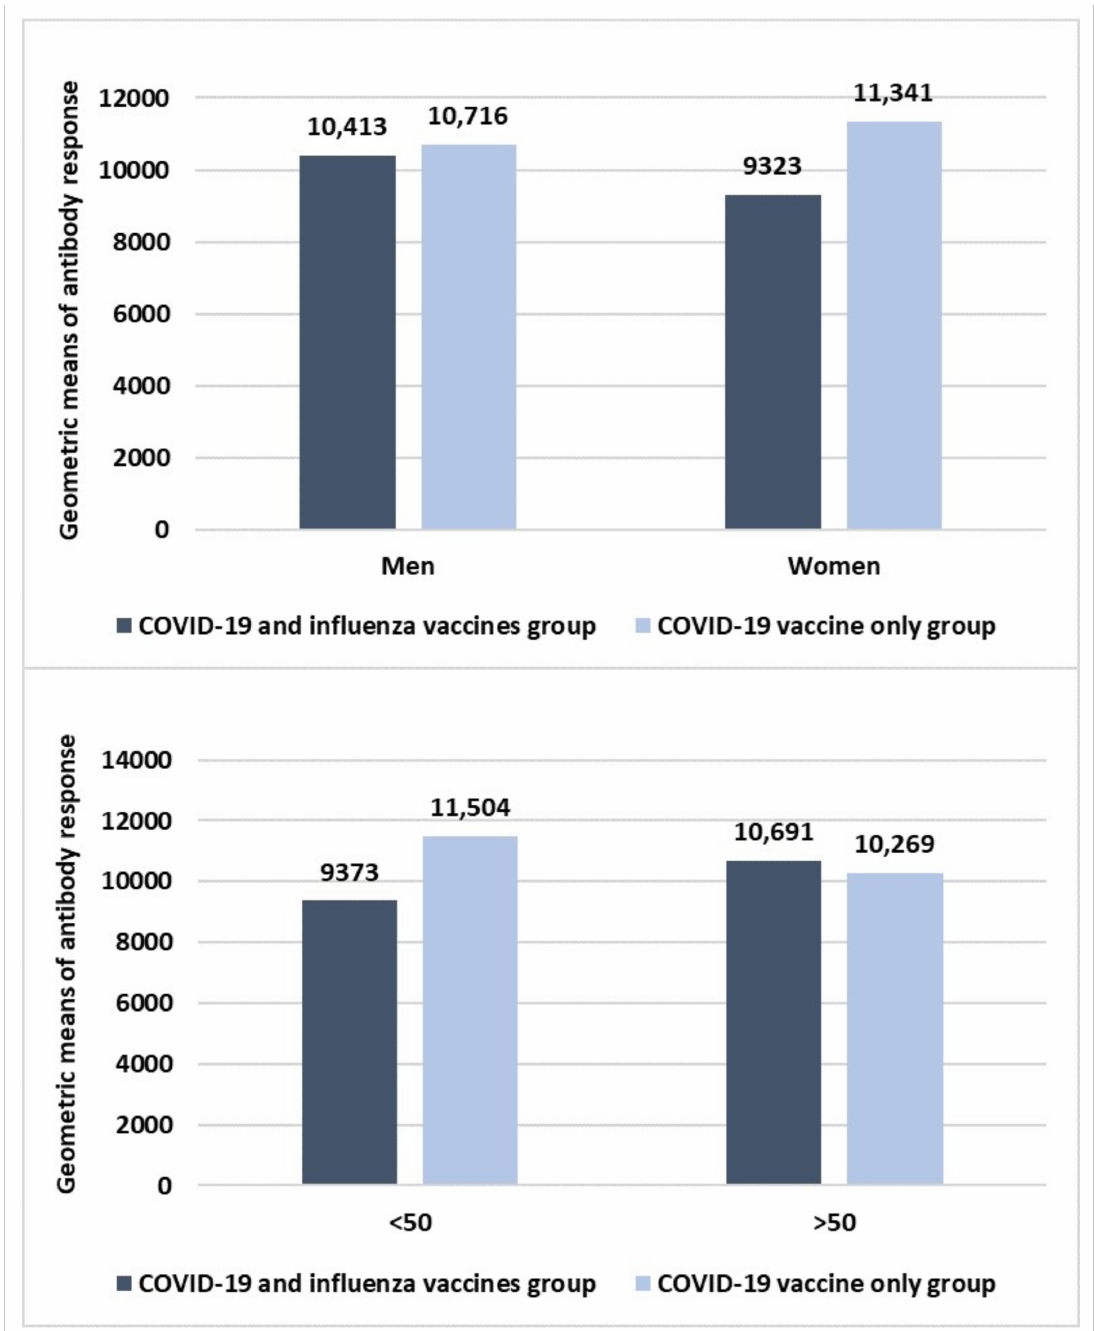
Figure 2. Sex and age differences in the immune response to the first booster dose of the COVID- 19 vaccine between COVID-19 and influenza vaccines and COVID-19 vaccine-only groups. Size sample of both the two groups: 64 HCWs. Student’s t -test was used to evaluate statistically significant